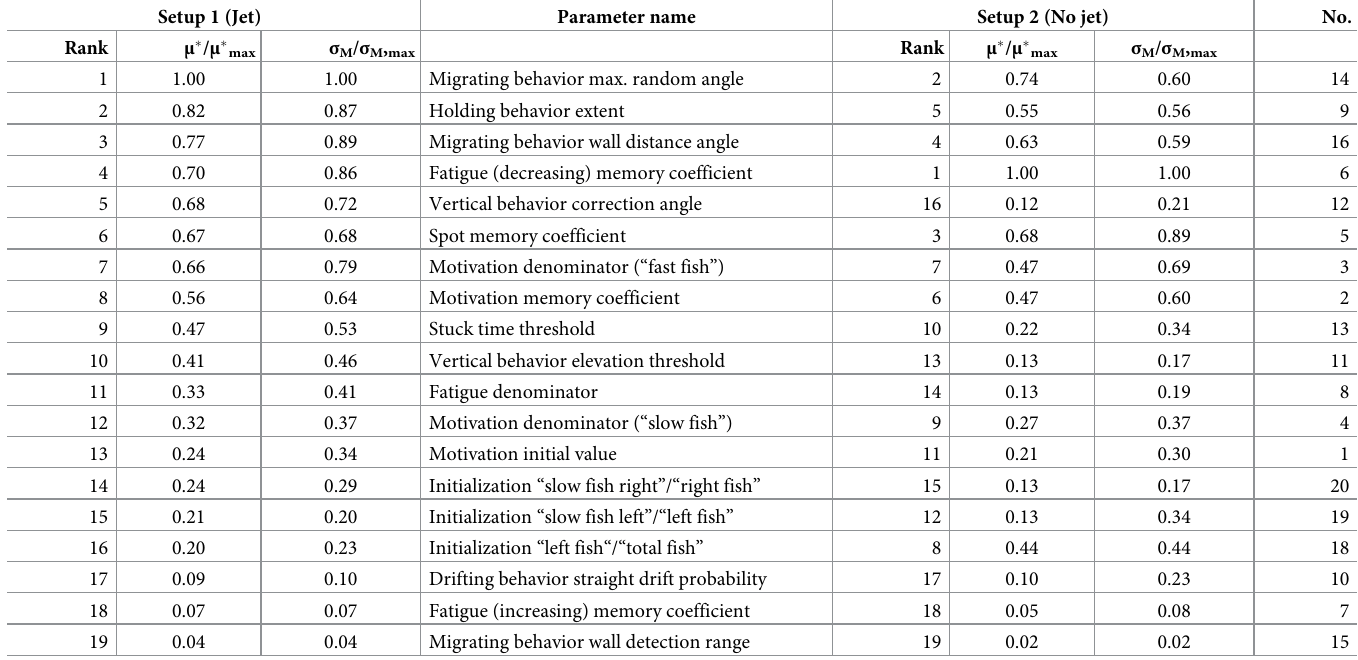
Table 2. Parameters of the behavioral model with wall distance stimulus, ranked by normalized influence, μ � /μ � max , in setup 1. Setup 1 (Jet)